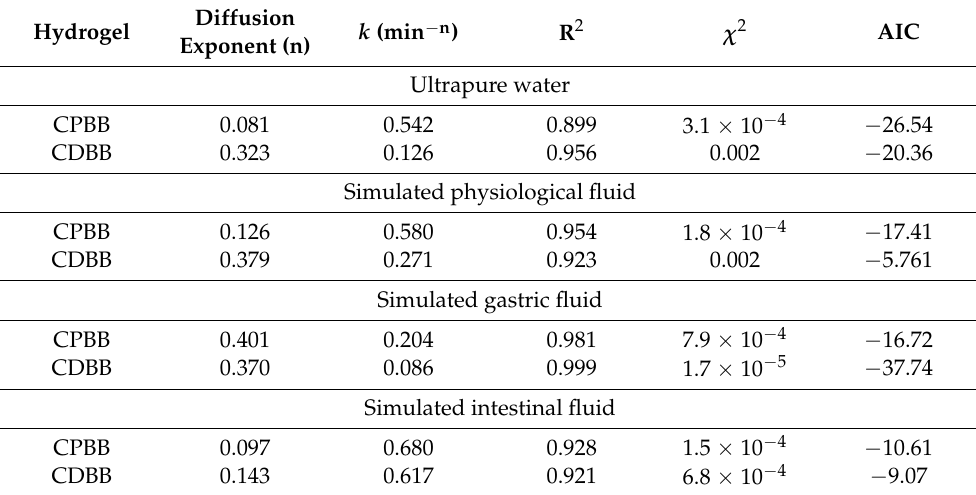
Table 1. Swelling parameters and error analyses for the absorption of water in chitosan/pectin (CPBB) and chitosan/DNA (CDBB) blend hydrogels in different media.